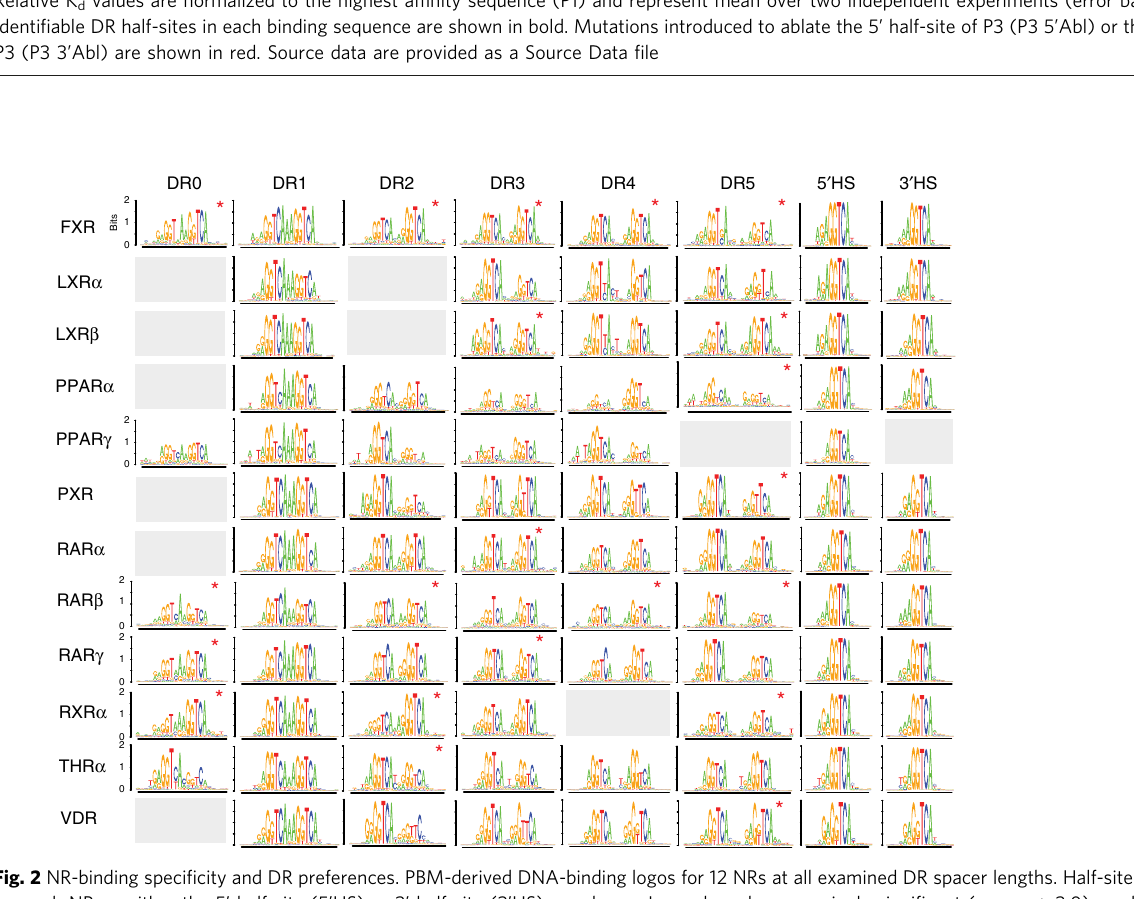
Fig. 2 NR-binding speci fi city and DR preferences. PBM-derived DNA-binding logos for 12 NRs at all examined DR spacer lengths. Half-site logos identi fi ed for each NR on either the 5 ’ half-site (5 ’ HS) or 3 ’ half-site (3 ’ HS) are shown. Logos based upon a single signi fi cant (z-score > 3.0) seed sequence are indicated ( ∗ ). Source data are provided as a Source Data fi